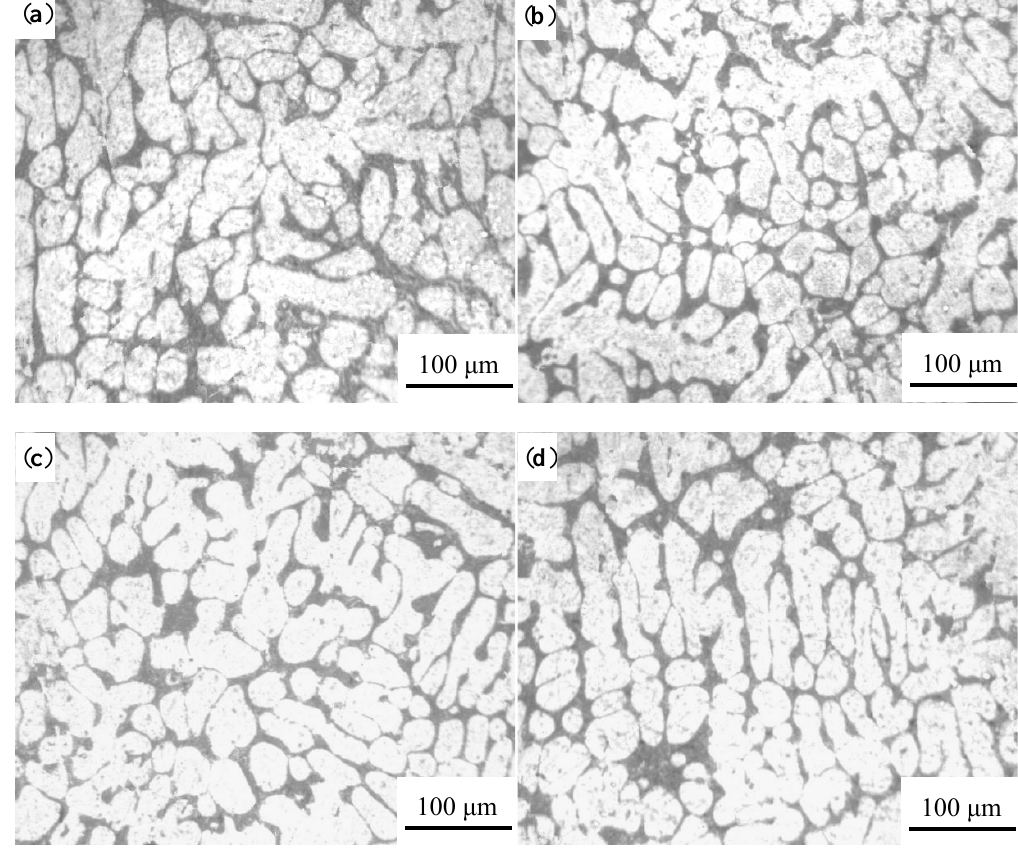
Figure 4. Microstructure of vacuum counter-pressure casting aluminum alloy under different pouring temperature; ( a ) 680 °C, ( b ) 700 °C, ( c ) 720 °C, ( d ) 740 °C.